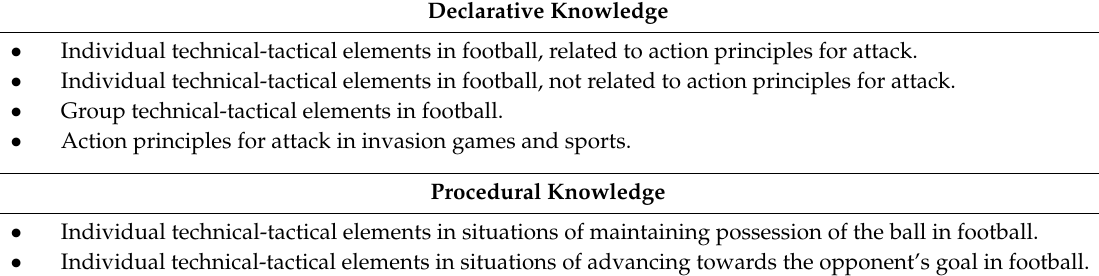
Table 2. Indicators evaluated by the